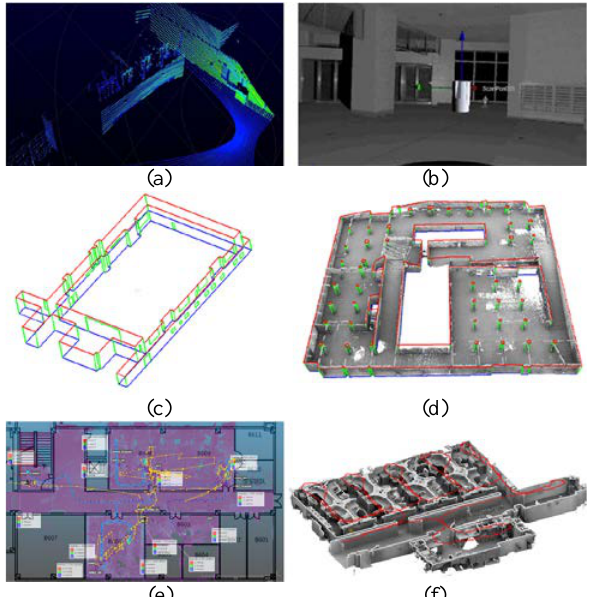
Figure 7. (a)A single frame from LiDAR stream. (b) An indoor view of Rigel VZ 1000 data. (c) BIM structure model of a circular corridor. (d) BIM structure model with its point cloud. (e) An example of the indoor positioning benchmark. (f) The ground- truth trajectory with the corresponding point